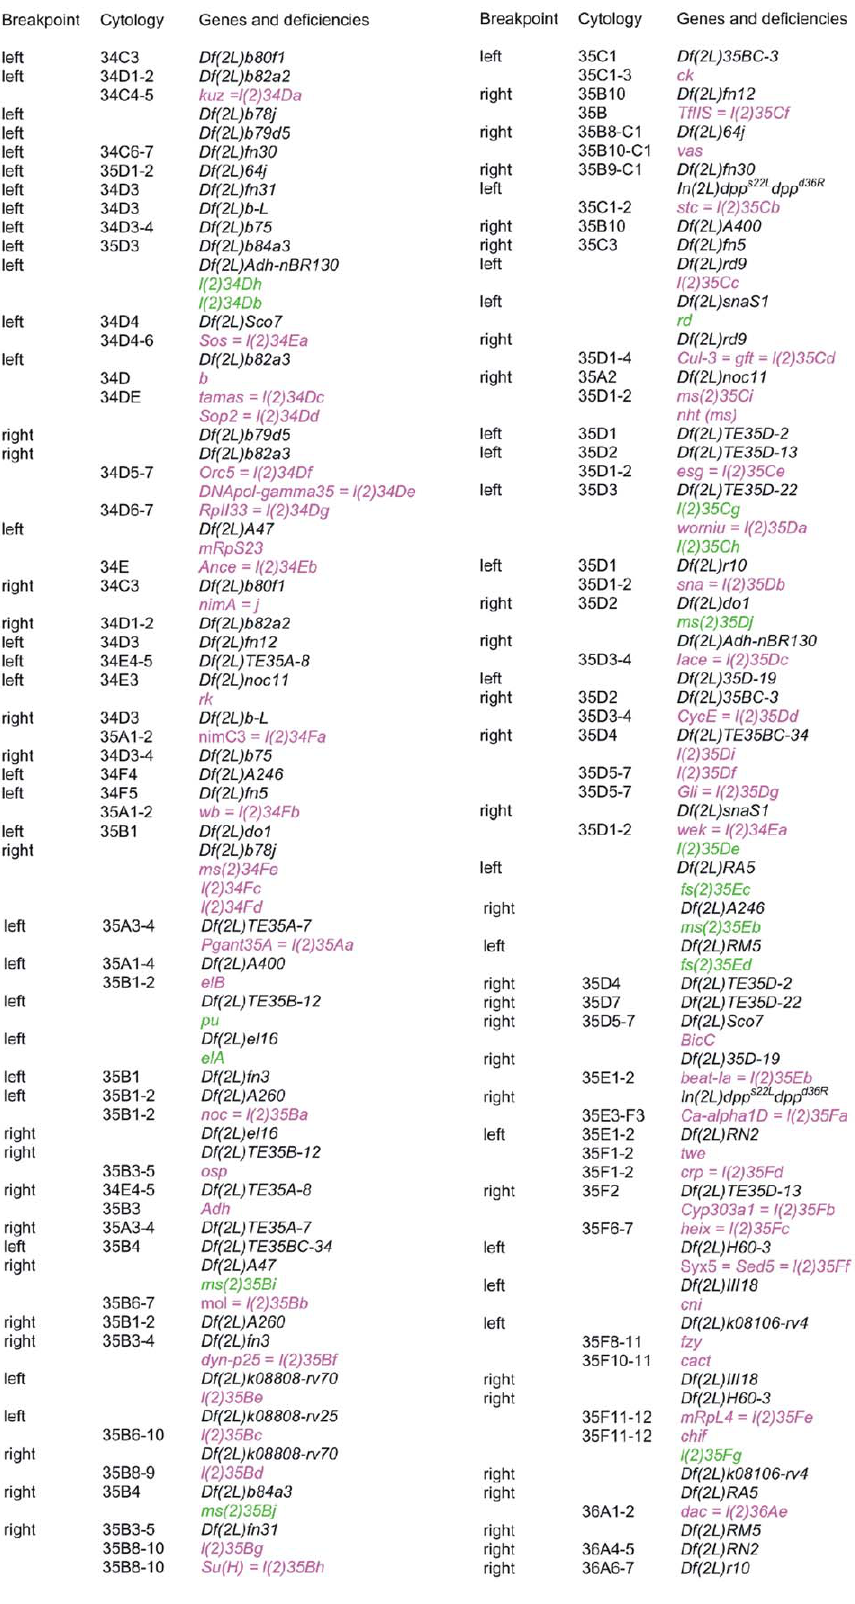
Figure 1. Cytogenetic map showing the deficiencies and genes in polytene chromosomeregion34C-36A. The cytological locations are only given for deletions or genes mapped on polytene chromosomes (which do not always correspond to the cytological locations given for the molecular map by the Drosophila Genome Project). Deficiency breakpoints localized on the molecular map are indicated in red and the non-localized breakpoints are indicated in black. Genes are in purple if the transcription unit has been identified, and in green if the transcription unit is not currently known. doi:10.1371/journal.pone.0055915.g001 PLOS ONE | www.plosone.org 3 February 2013 | Volume 8 | Issue 2 |